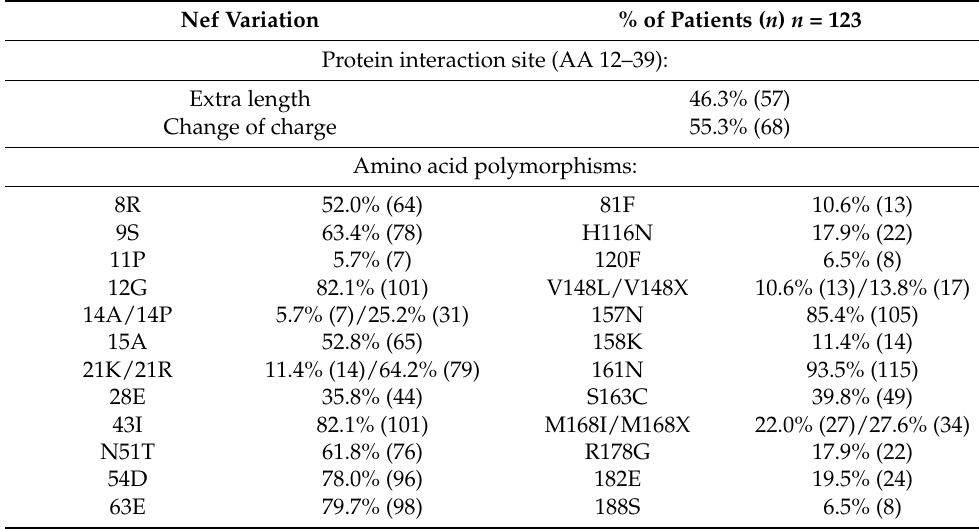
Figure 1. Amino acid variation in Nef. HIV-1 consensus B Nef. The red boxes indicate previously identified amino acid polymorphisms [14,25,26]. The green boxes highlight known binding sites of Nef in which naturally occurring variations and amino acid polymorphisms occur. Table 1. Amino acid variation in HIV-1 obtained from individuals with